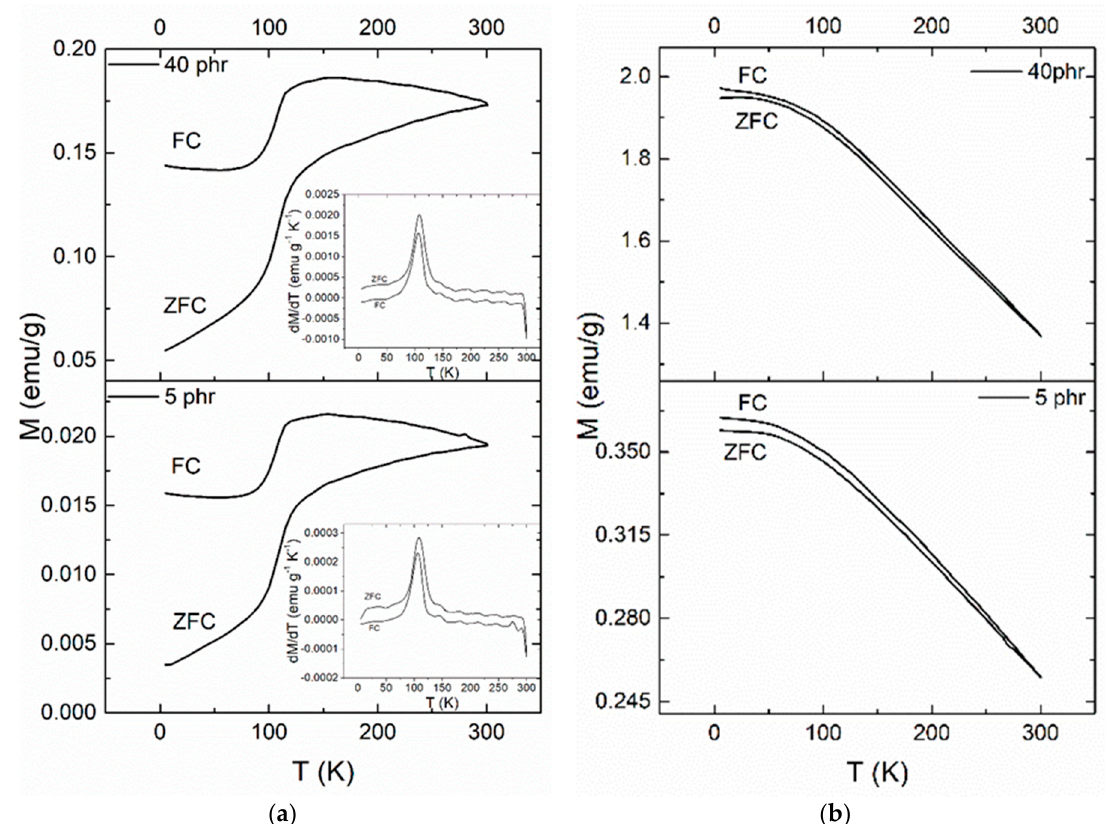
Figure 12. The ZFC and FC magnetization curves for the 5 and 40 phr nanocomposites with: ( a ) BaFe 12 O 19 ; ( b ) SrFe 12 O 19 filler content. Inset in ( a ) depicts the 1st derivative of the ZFC and FC magnetization curves versus temperature for the 5 and 40 phr BaFe 12 O 19 nanocomposites.